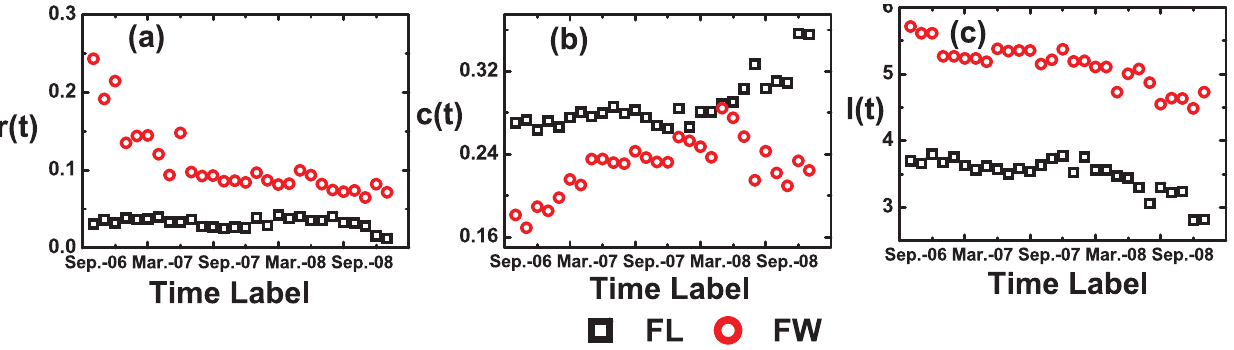
Figure 4. (Color online) The topological properties of the cores. (a) the assortative coefficient r(t) is decreasing from 0.25 to 0.1 in the FL network, and fluctuating around 0.05. (b) the average clustering coefficient c(t) is increasing slightly. (c) the average shortest path length of the core l(t) are decreasing from 3.5 to 3 in the FL network and from 5.7 to 4.5 in the FW network.